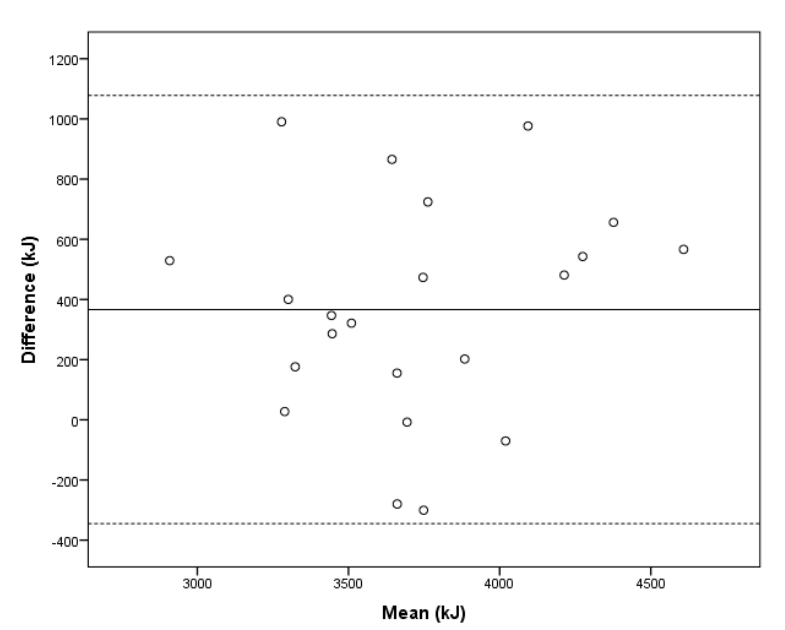
Figure 2. Bland–Altman plot showing the mean versus the difference in energy intake estimated from food records with active image-assistance and metabolizable energy calculated from doubly labeled water in 22 healthy, 12-month-old infants. The x -axis shows the mean energy intake (EI) per day (kJ) from FR with image-assistance and metabolizable energy. The solid line (-) shows the mean difference of 366 kJ, and the dashed lines (—) show the 95% limits of agreement ( ± 1.96 SD) of 712